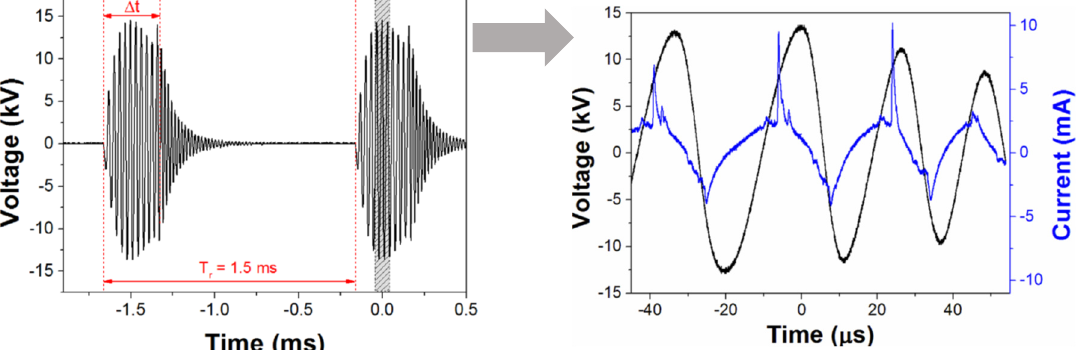
Figure 11. Waveform of the modulated voltage applied to a flexible capillary with inserted Cu wire. Plot followed by a detailed view of applied voltage and plasma currents signals measured in the time interval from the dashed rectangle. Reprinted/adapted with permission from Ref. [50]. Copyright 2015, WILEY-VCH Verlag GmbH & Co.